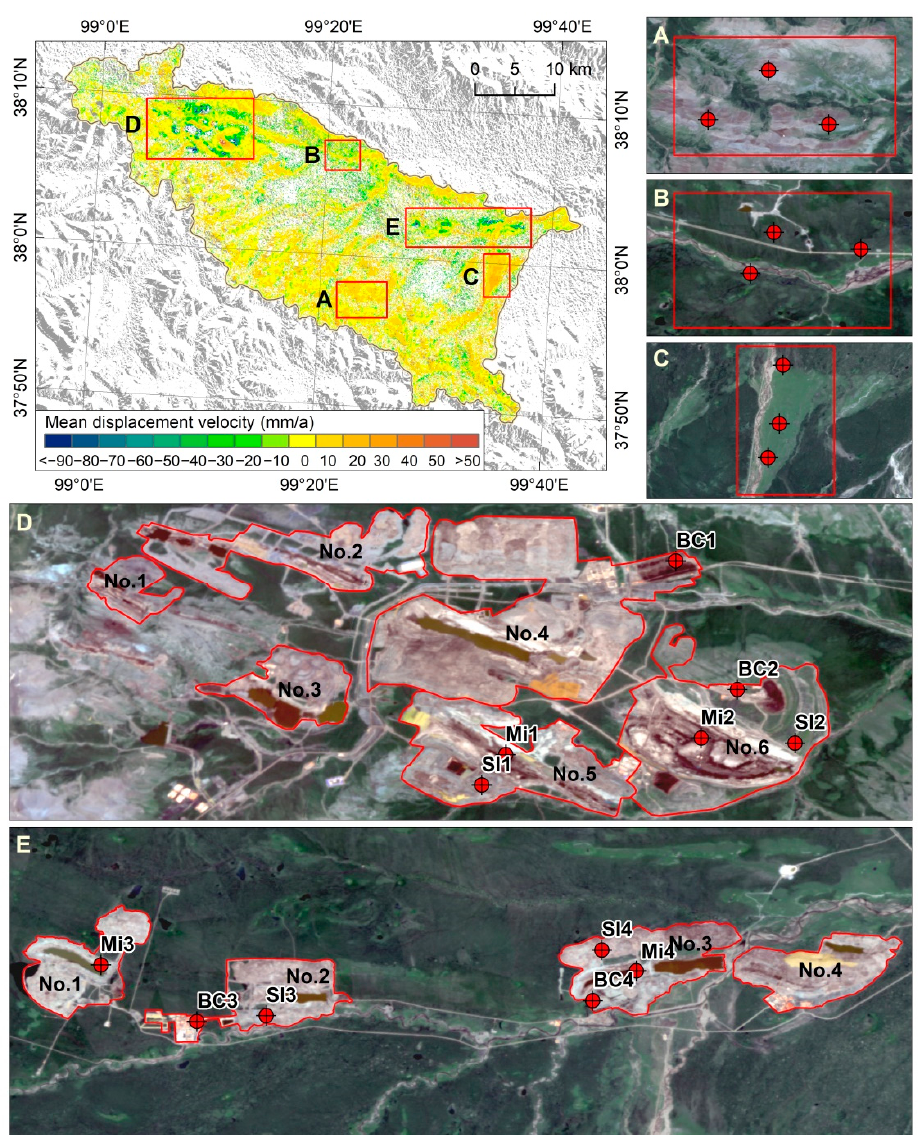
Figure 3. Spatial distribution of mean displacement velocity in the Muli region from 2018 to 2020 (Positive and negative values represent uplift and subsidence along the line-of sight (LOS), respectively). Notes: (1) ( A ): stable region of mountain bare rock; ( B ): subsidence region of alpine marsh meadow; ( C ): uplift region of alpine meadow; ( D ): JHG mining area; ( E ): JC mining area.